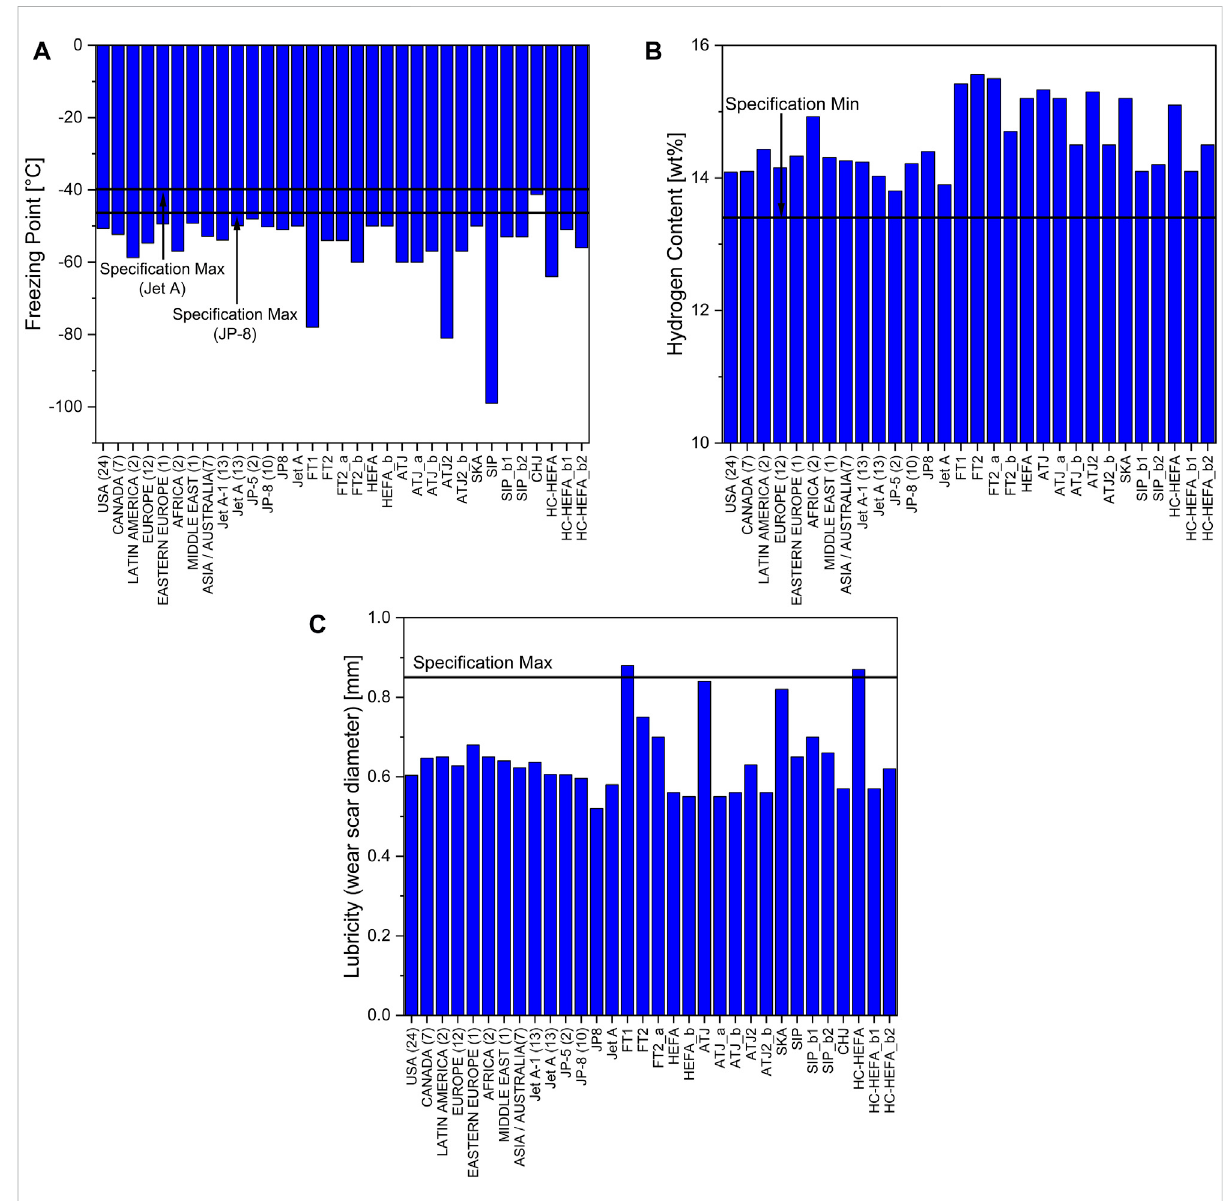
FIGURE 8 Results for WFS and SAF (A) freezing point (Jet A, JP 8), (B) hydrogen content, (C)